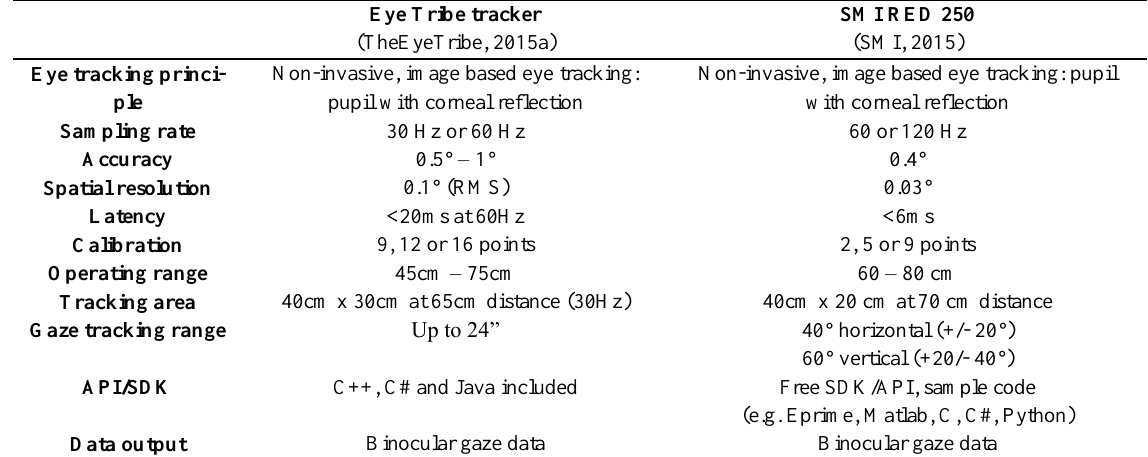
Table 1: Technical specifications of both eye tracking